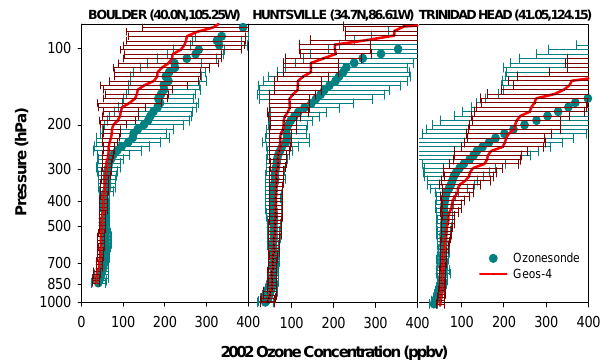
Fig. 1. Yearly variability of GEOS-Chem outputs verses ozonesonde. Fig. 2. Yearly variability of GEOS-Chem outputs verses